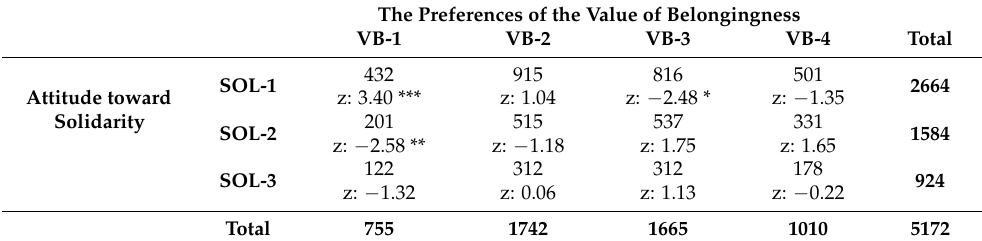
Table 5. Relationship between the preferences for the value of belongingness and solidarity (SOL). The Preferences of the Value of Belongingness